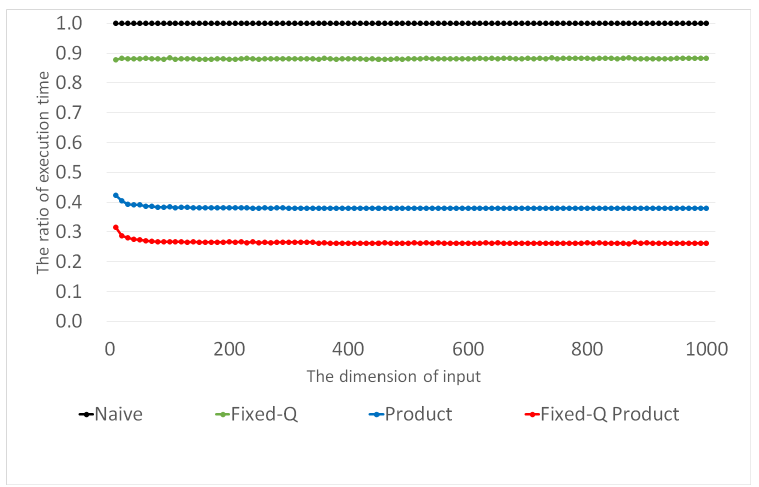
Figure 3. Comparison of the performance ratio of other methods to compute inner-pairing products compared to the Naive